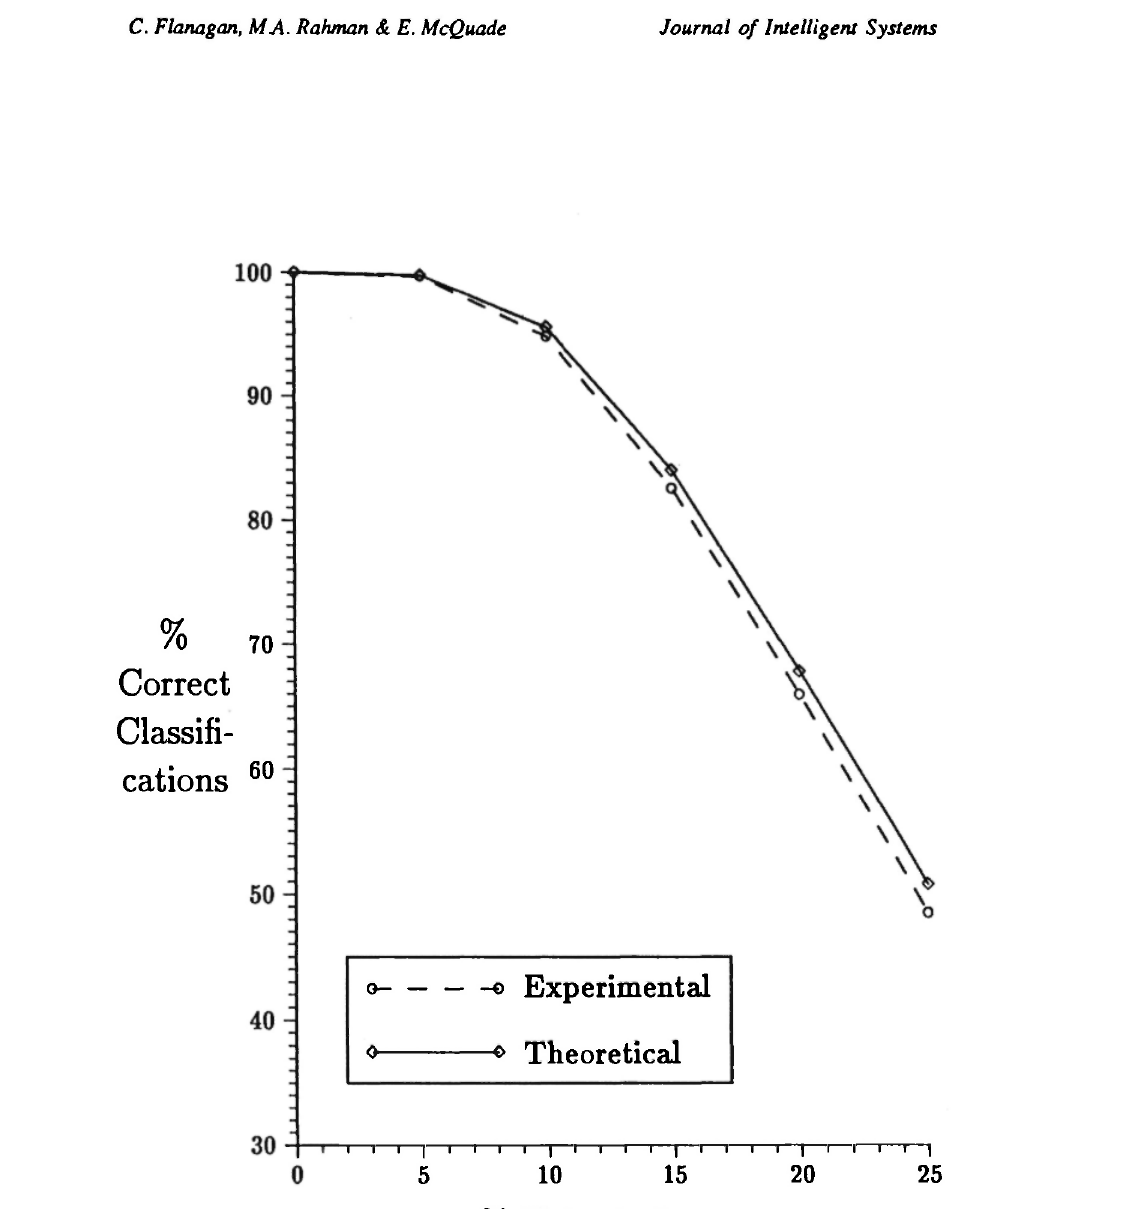
Fig. 16 8-tuple classifier. Theoretical predictions from the N-tuple equation and experimental results. 9-bit Hamming distance